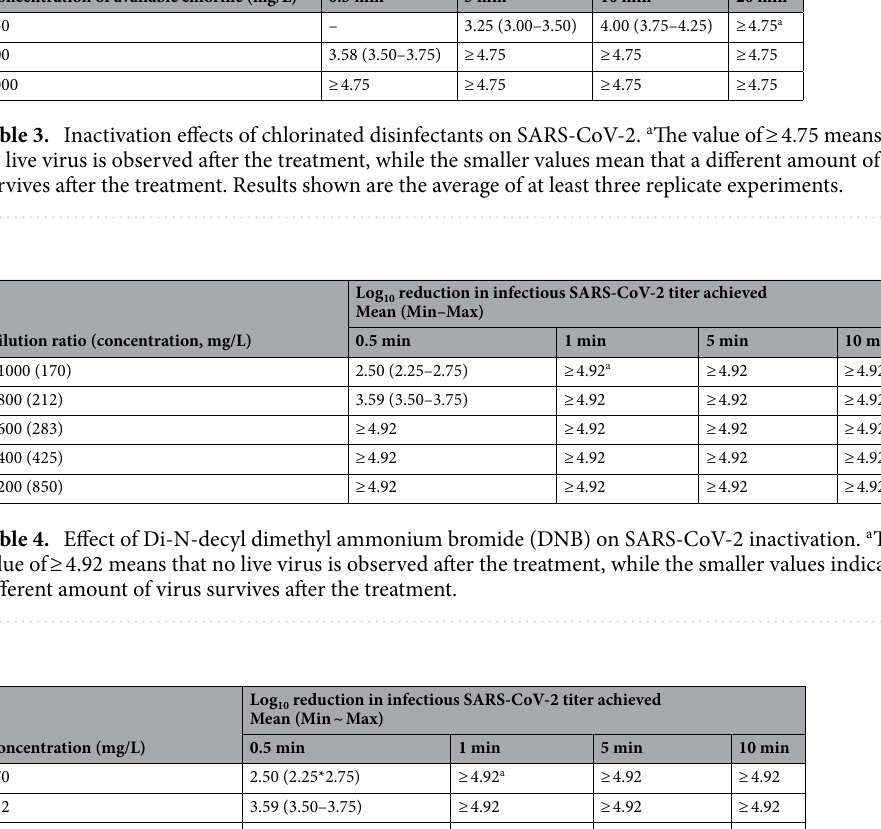
Concentration (mg/L)